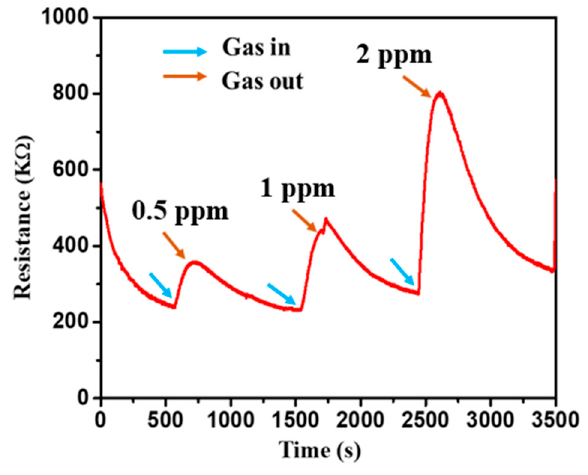
Figure 7. The sensor response of the SnO 2 device at room temperature at different concentrations of 0.5, 1, and 2 ppm of NO 2 at room temperature.